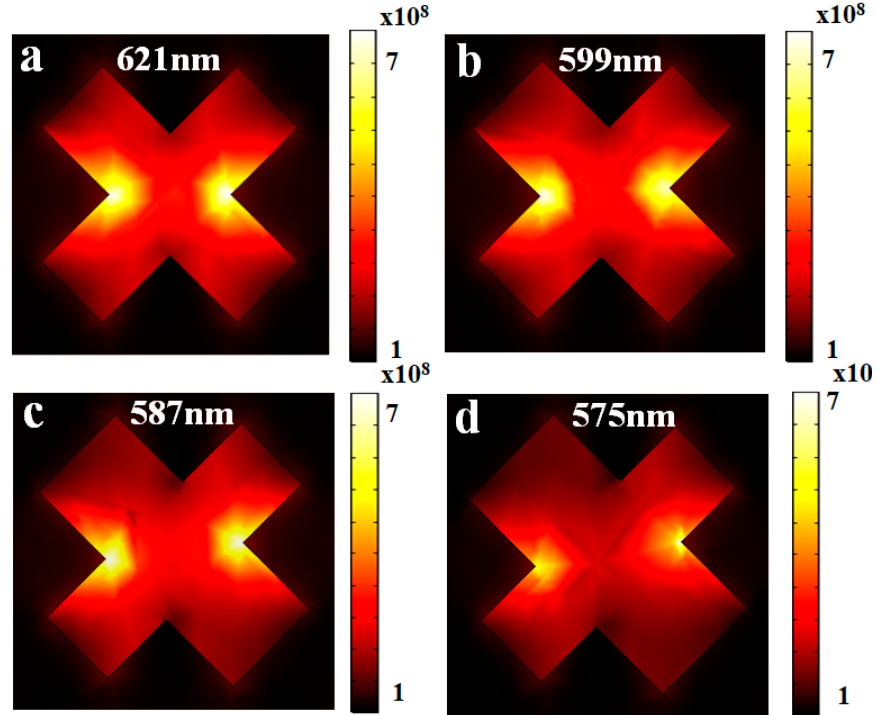
Figure 13. Electric field distribution at wavelengths 621 nm ( a ), 599 nm ( b ), 587 nm ( c ), and 575 nm ( d ) for defective structure for d5.